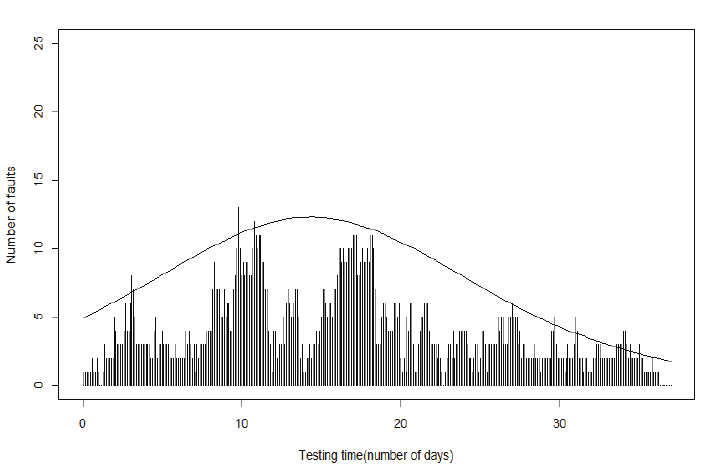
Figure 9. Behavior of the number of faults being corrected (the correction time is 0.5 day/fault on average, ISS